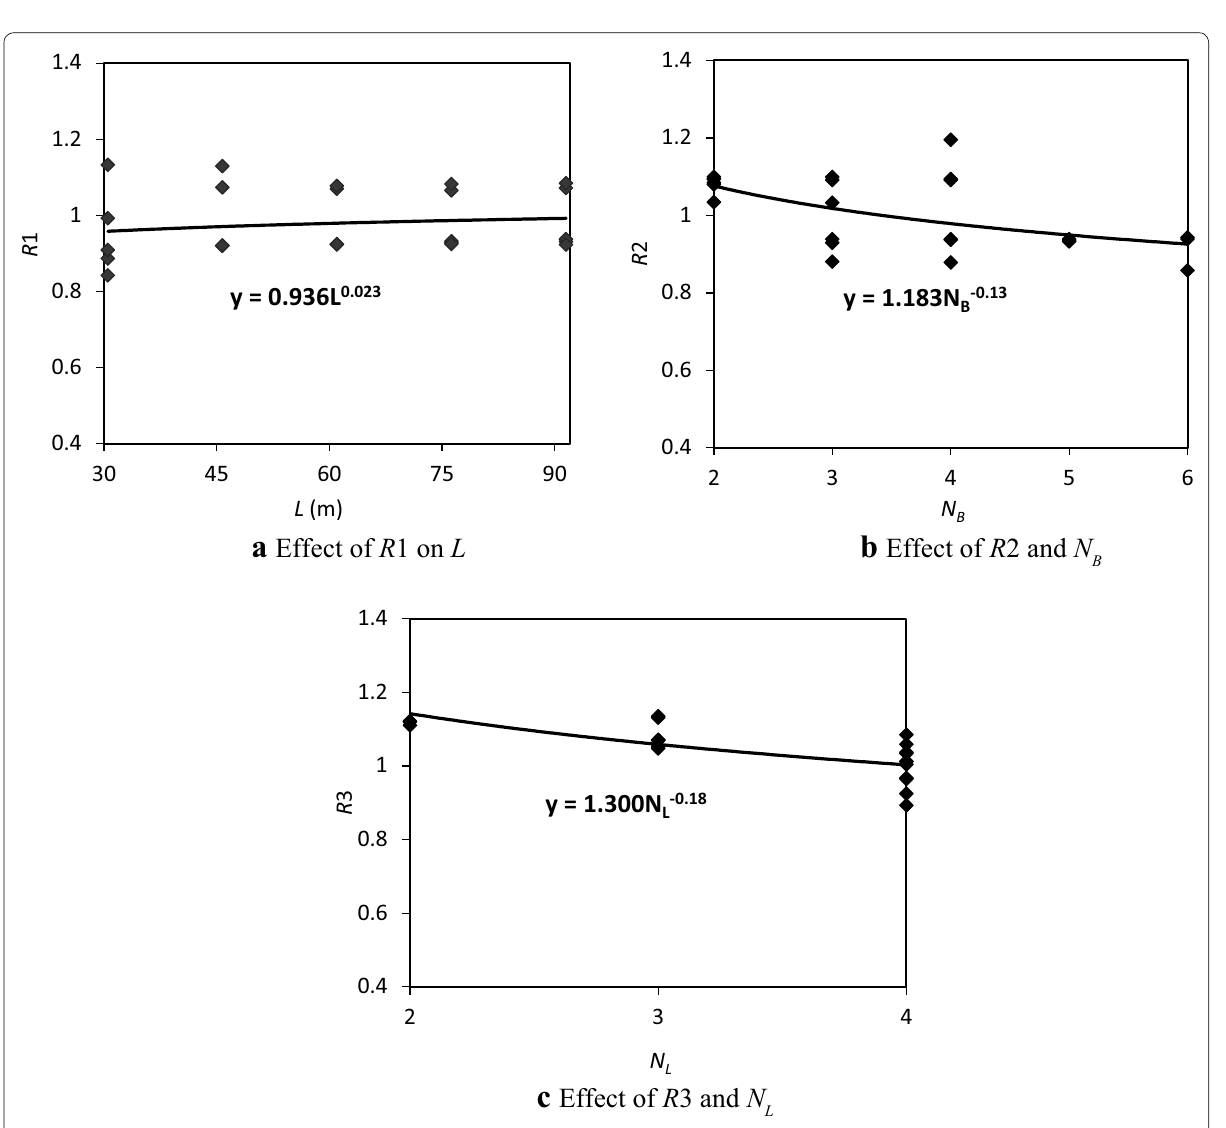
Fig. 14 Minimum least square fit to determine effect of various parameters on tensile stress distribution